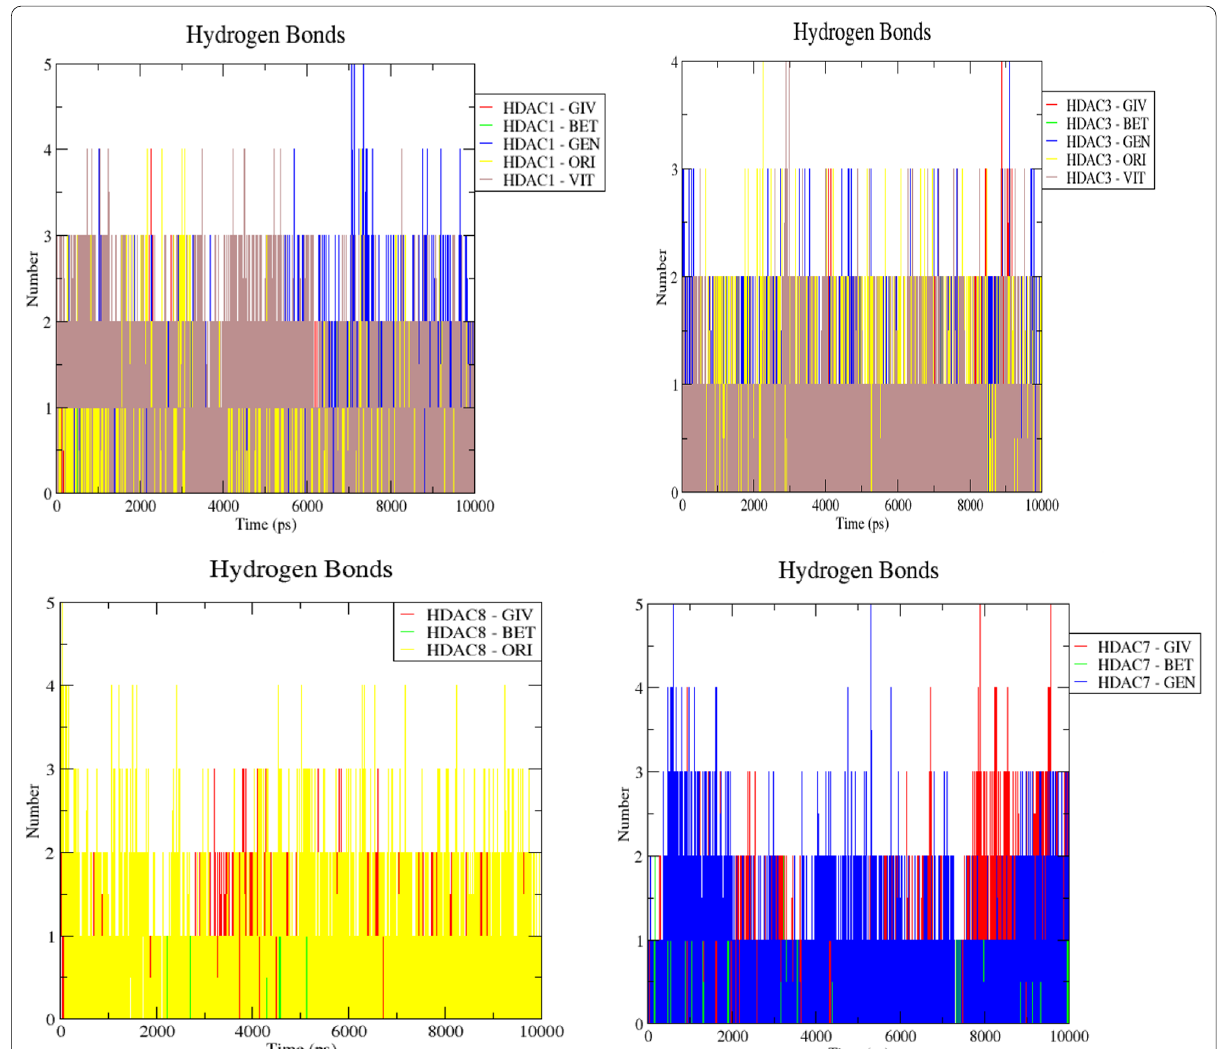
Fig. 12 The 2-D diagram describing the dynamics observed in the hydrogen bonding patterns for HDAC1, HDAC3, HDAC8 and HDAC7